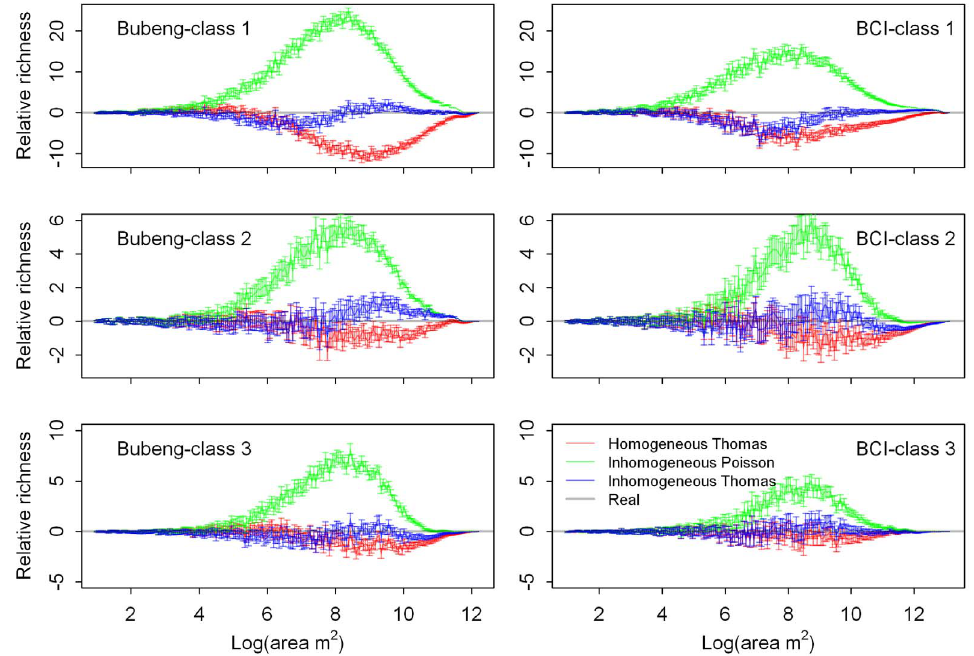
target tree species in the corresponding quadrats. This model,